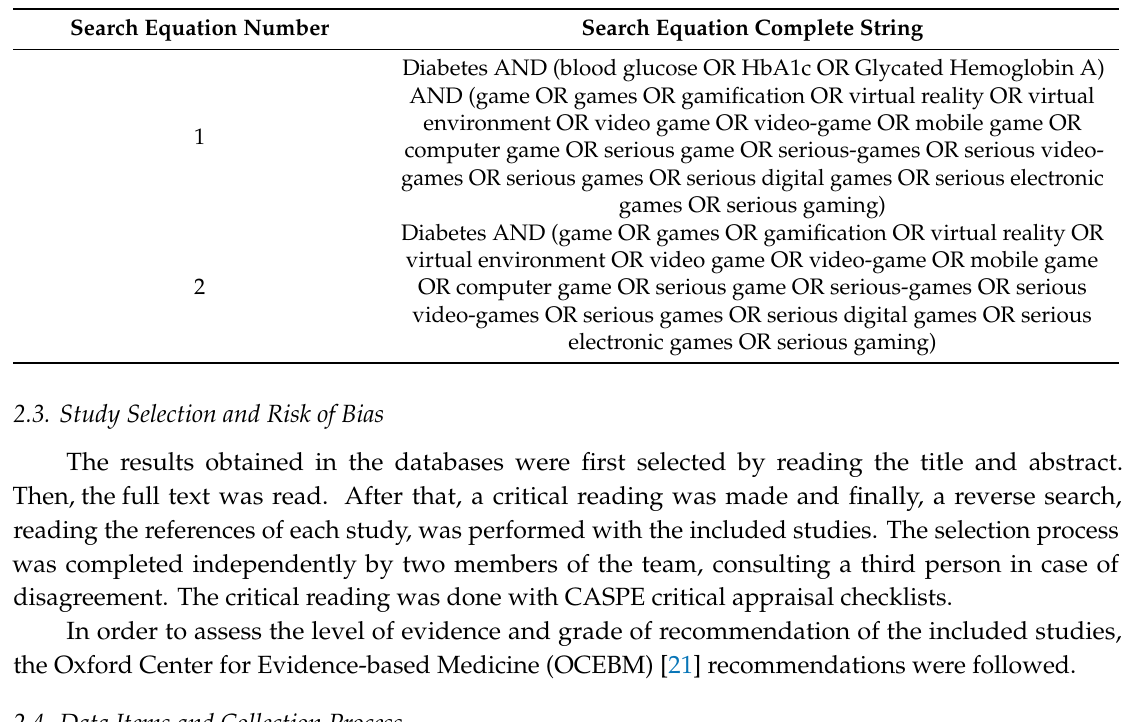
Table 1. Search equation